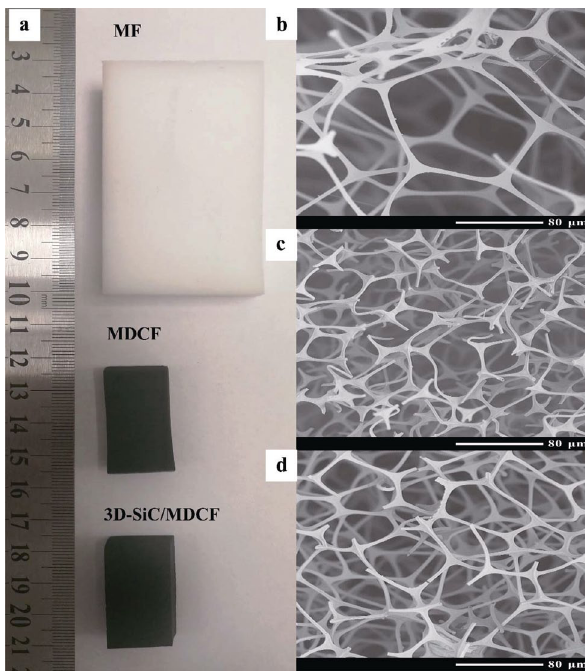
Fig. 2 Evolution progresses of MF, MDCF, and 3D-SiC/ MDCF: (a) overview images of samples; microstructures of (b) MF, (c) MDCF, and (d) 3D-SiC/MDCF.